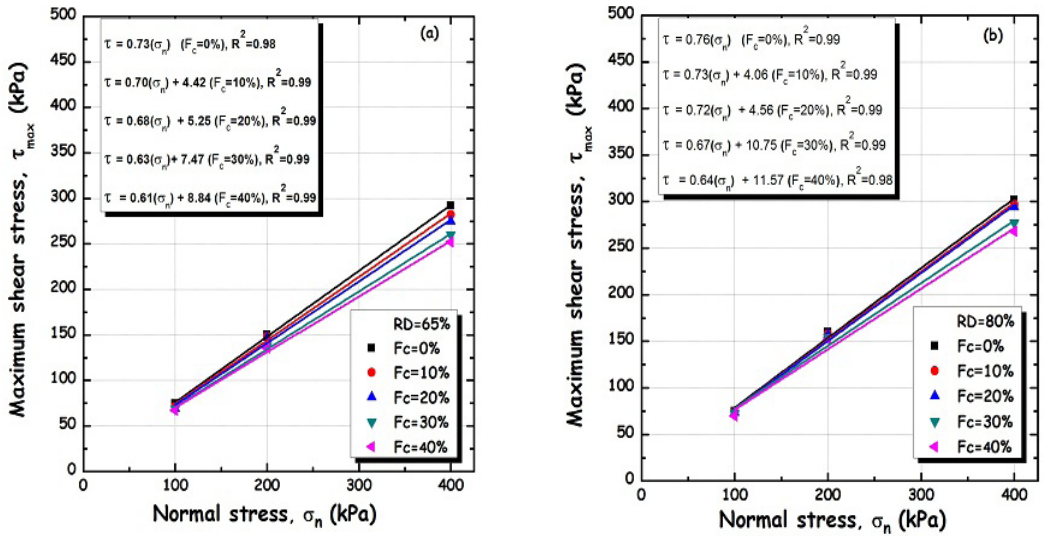
Figure 21: Effect of fines content on the mechanical behaviour of sand-silt mixtures: Maximum shear stress versus normal stress (w =